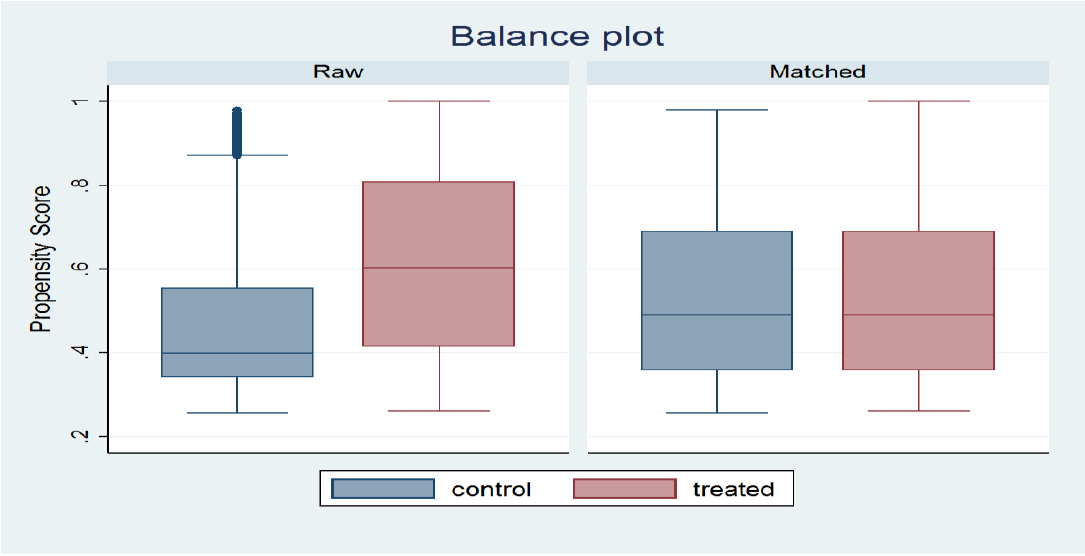
Figure A2. Covariates balancing test.